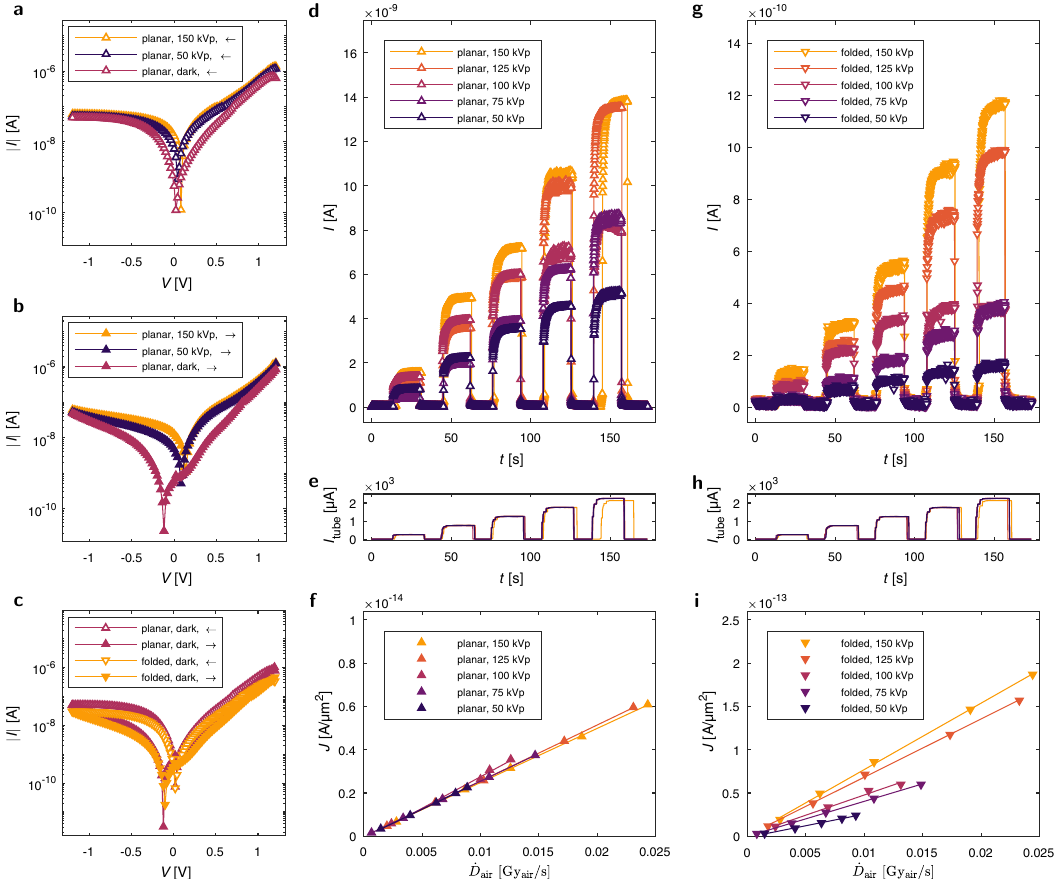
Fig. 2 Electrical characterization and X-ray sensitivity analysis. a , b Current – voltage characteristics ( I – V curves) of the pixel in the planar con fi guration based on backward ( a ) and forward ( b ) voltage scanning. The I – V curves are measured in the dark, under 50 kVp, and under 150 kVp X-ray radiation. c Comparison of the I – V curves of the pixel measured in the initial planar and in the folded con fi guration. The arrows in the legend entries in ( a – c ) indicate the utilized voltage scanning direction. d , g Time-resolved current I ( t ) of the pixel in the planar and in the folded con fi guration under pulsed 50 kVp − 150 kVp X-ray radiation. e , h Respective time-resolved X-ray tube current I tube ( t ) that is stepwise increased to realize different X-ray intensities at constant X-ray tube accelerating voltages. f , i Current densities J as a function of the applied dose rate in air _ D air calculated from the measured pixel currents shown in ( d , g ). The results of the respective linear fi ts are additionally